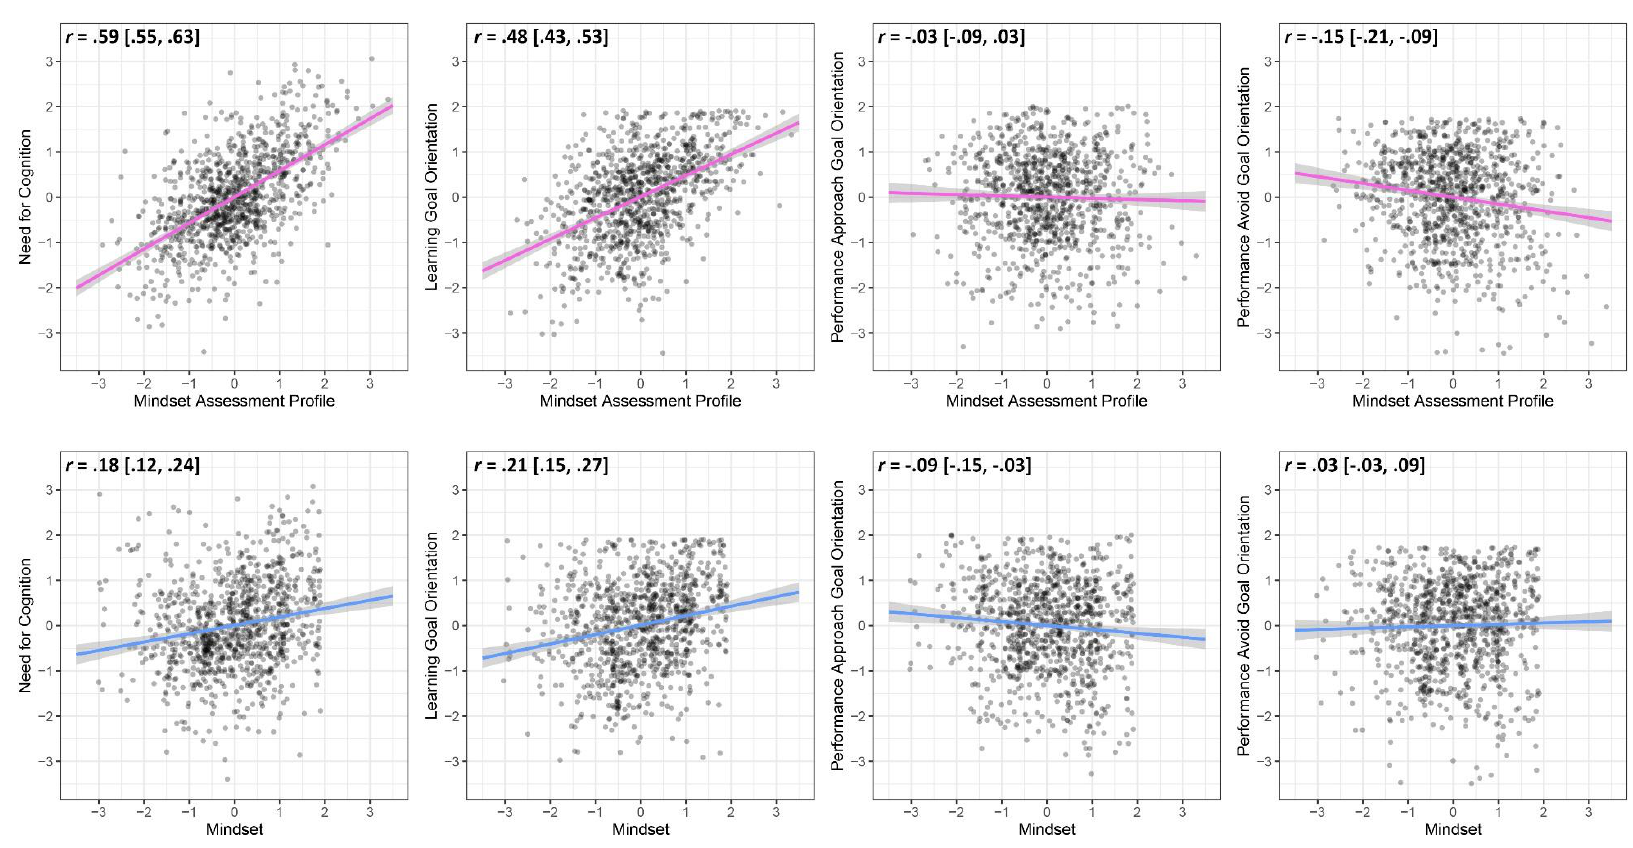
Figure 2. Scatterplots depicting correlations between Mindset Assessment Profile scores and other measures (top row) and between mindset and other measures (bottom row). Note. “Mindset” refers to the Implicit Theories of Intelligence Questionnaire. All scores are standardized (i.e., z -scores).